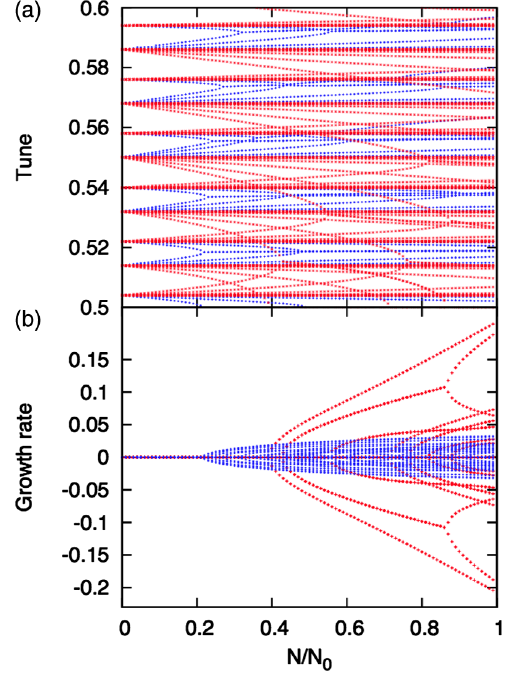
FIG. 16. Eigenvalues of the σ modes as a function of the bunch ¼ 0 . 55 population for the FCC-ee-Z parameter, where ν x ν ¼ 0 . 018 . (a) Tune near ν ¼ 0 or 1. (b) Growth rate in the tune z range 0 . 5 < ν < 0 . 7 (blue), 0 . 7 < ν < 0 . 8 (green), and ν > 0 . 8